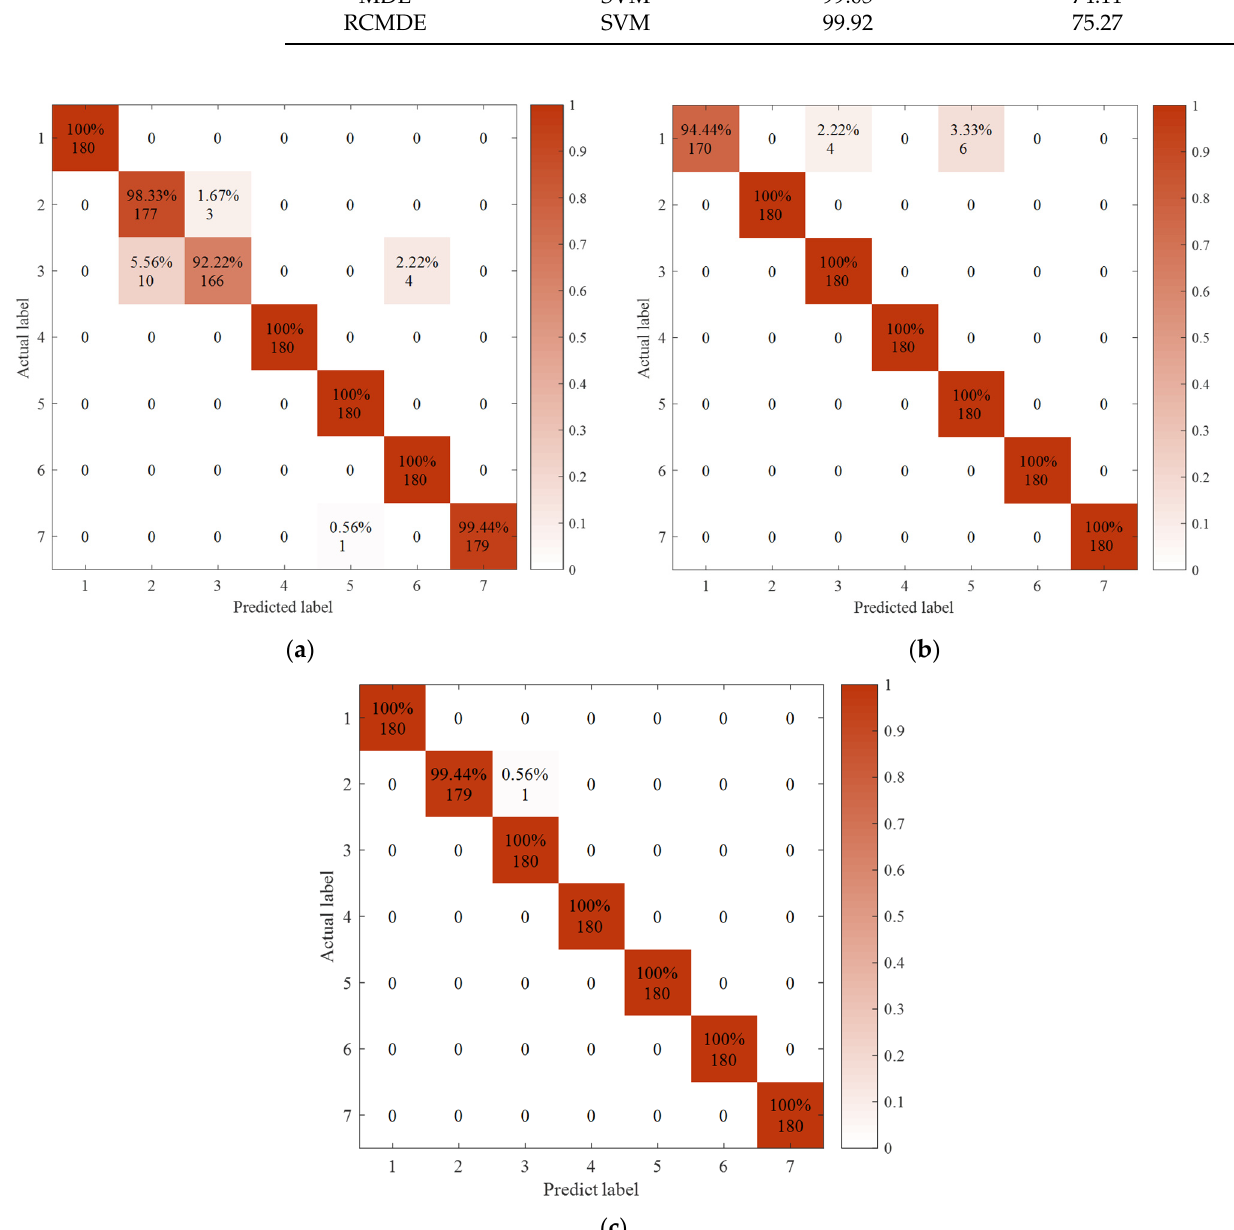
Figure 6. The confusion matrix of different feature-extraction methods: ( a ) MSE; ( b ) MDE; ( c ) RCMDE.